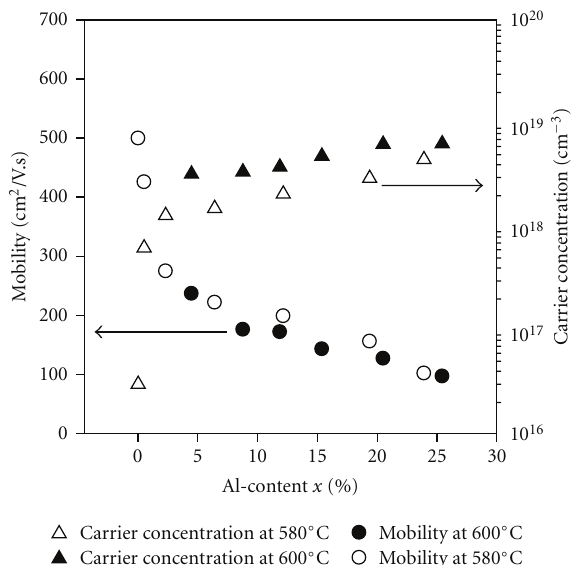
Figure 4: Mobilities and carrier concentration (300K) for Al x Ga 1 − x Sb layers grown at 580 ◦ C and 600 ◦ C as a function of Al- content (mol-% AlSb).